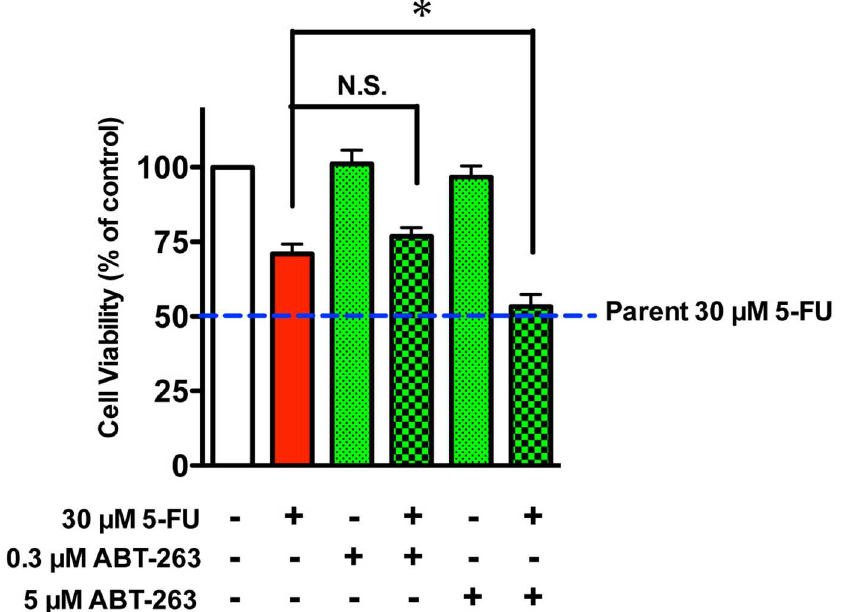
Fig 6. Effect of ABT-263 on the cytotoxicity of 5-FU against MDA-MB-231BR. Cytotoxicity of 5-FU to MDA-MB-231BR in the presence of 0.3 or 5 μ M ABT-263. Blue broken lines parallelto x-axis represent the cell viability of MDA-MB-231 (Parent) treated with 30 μ M 5-FU. Data represent the mean with SEM of four independent samples ( * P < 0.05, BR treated with 30 μ M 5-FU vs . BR treated with 30 μ M 5-FU and 5 μ M ABT-